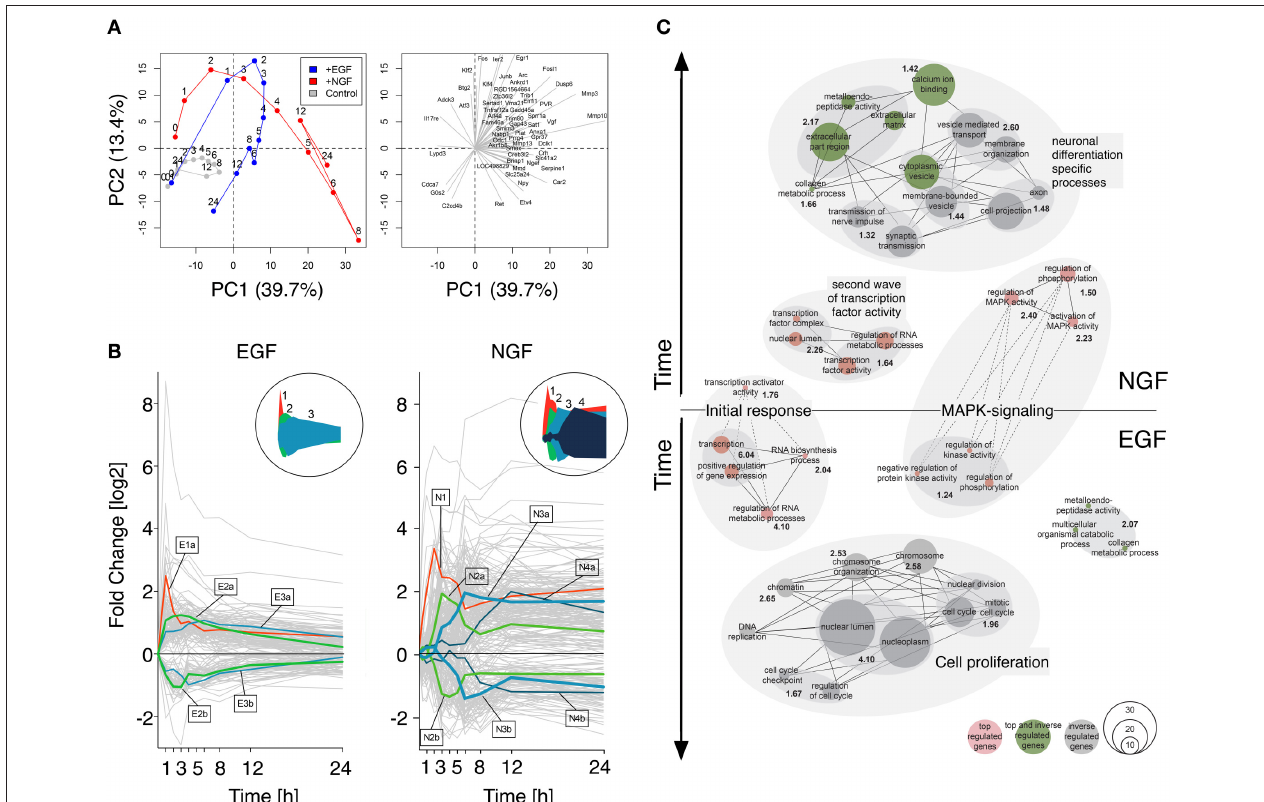
FIGURE 1 | Gene response dynamics after NGF or EGF stimulation. (A) Principal component analysis (PCA) of the PC12 cell transcriptomes after NGF (red), EGF (blue) and control treatment (gray). The PCA scores (left panel) and loadings (right panel) correspond to the samples and genes, respectively. Samples in the left panel have been connected to guide the eye. Clearly, EGF and NGF samples remain close in the first 3 h and separate at later timepoints, indicating a different cellular phenotype. Right panel: 50 largest loading vectors indicating the impact and time of action of individual genes. Immediate early genes, like Fos or Ier2 point toward early timepoints, while loadings pointing toward the right, like Vgf or Npy , correspond to late timepoints and are most likely involved in differentiation. (B) Expression clusters of top regulated genes. The left and right panels depict the response of individual genes to EGF and NGF stimulation, respectively (gray lines). Cluster centroids are marked by lines with the cluster size encoded by line thickness. The circular inserts depict the cluster centroid envelopes for EGF and NGF, respectively. (C) Network representation of functional enrichment of NGF and EGF response genes. The network is comprised of GO-term clusters having a significant enrichment ( − log 10 ( p -value) > 1.3 ) as shown in bold black numbers. Red, gray and green nodes contain in this order top-regulated genes, inversely-regulated genes between EGF and NGF or both. The vertical node location corresponds to the peak regulation of their genes, while node size is proportional to the number of genes in a functional category. Edges indicate a gene overlap of > 20 % between nodes, being drawn as dashed lines, if they are shared between EGF and